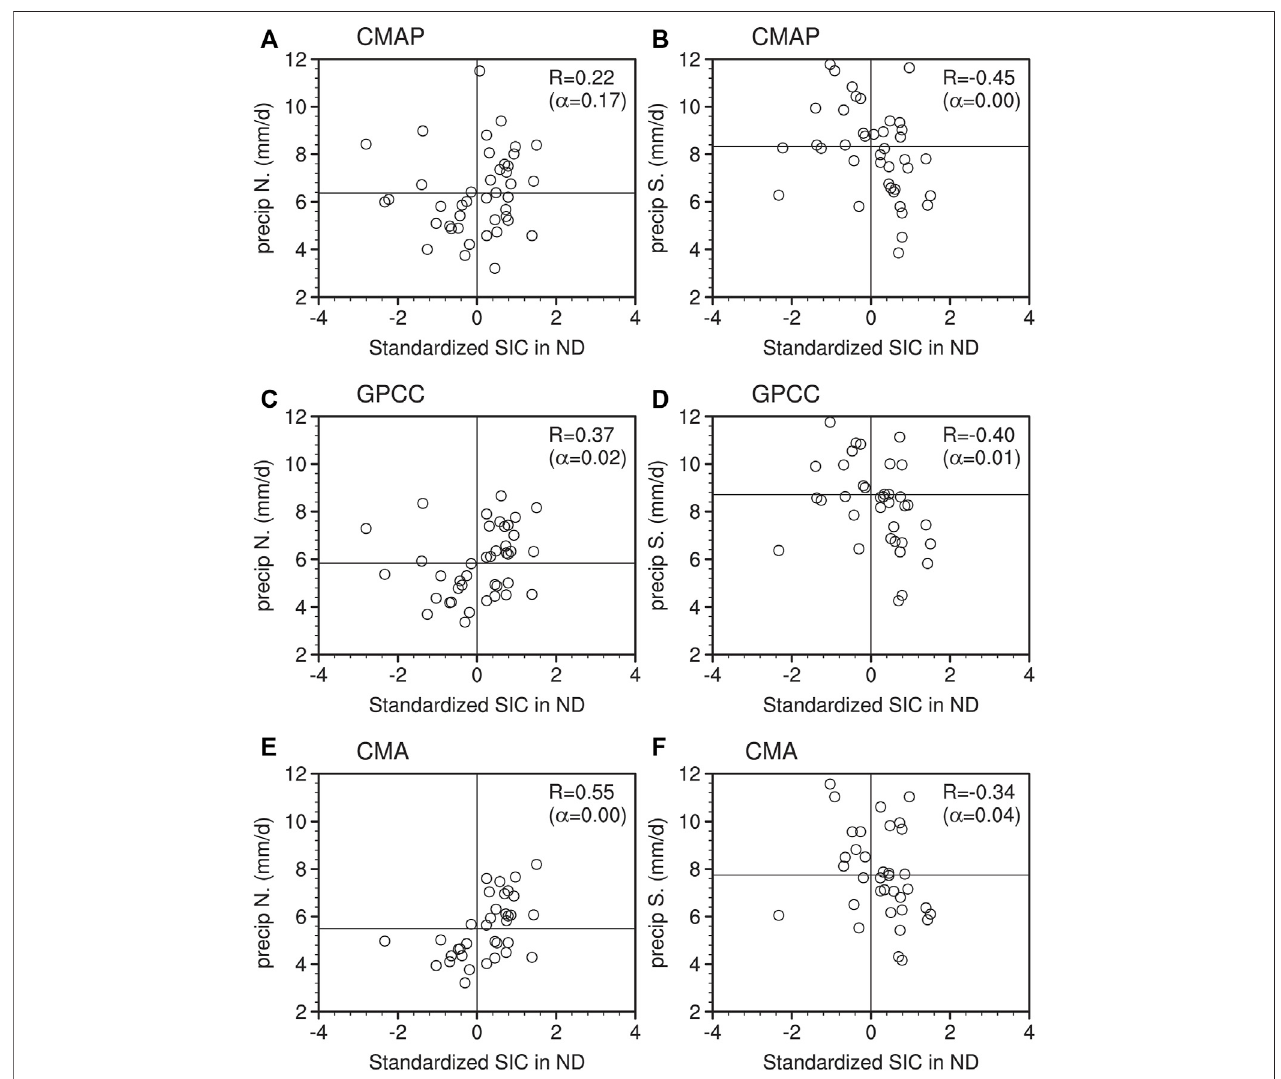
FIGURE4| ScatterplotsofthestandardizedNovember – DecembermeanseaiceconcentrationinBarents – KaraSeasversustheprecipitationsinthenorth (A) , (C) , (E) and south (B) , (D) , (F) box in Figures 2D – F for three rainfall datasets. The correlation between the sea ice and precipitation and its signi fi cance level are also printed on the top right for each